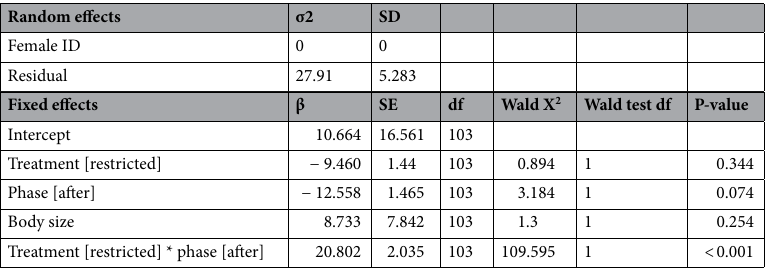
Table 2. Short-term experiment: results of a linear mixed model testing the treatment effects of limiting resources on fecundity (during and after the treatment). Parameter estimates and SEs were calculates using REML models. N Control = 26; N Restricted =